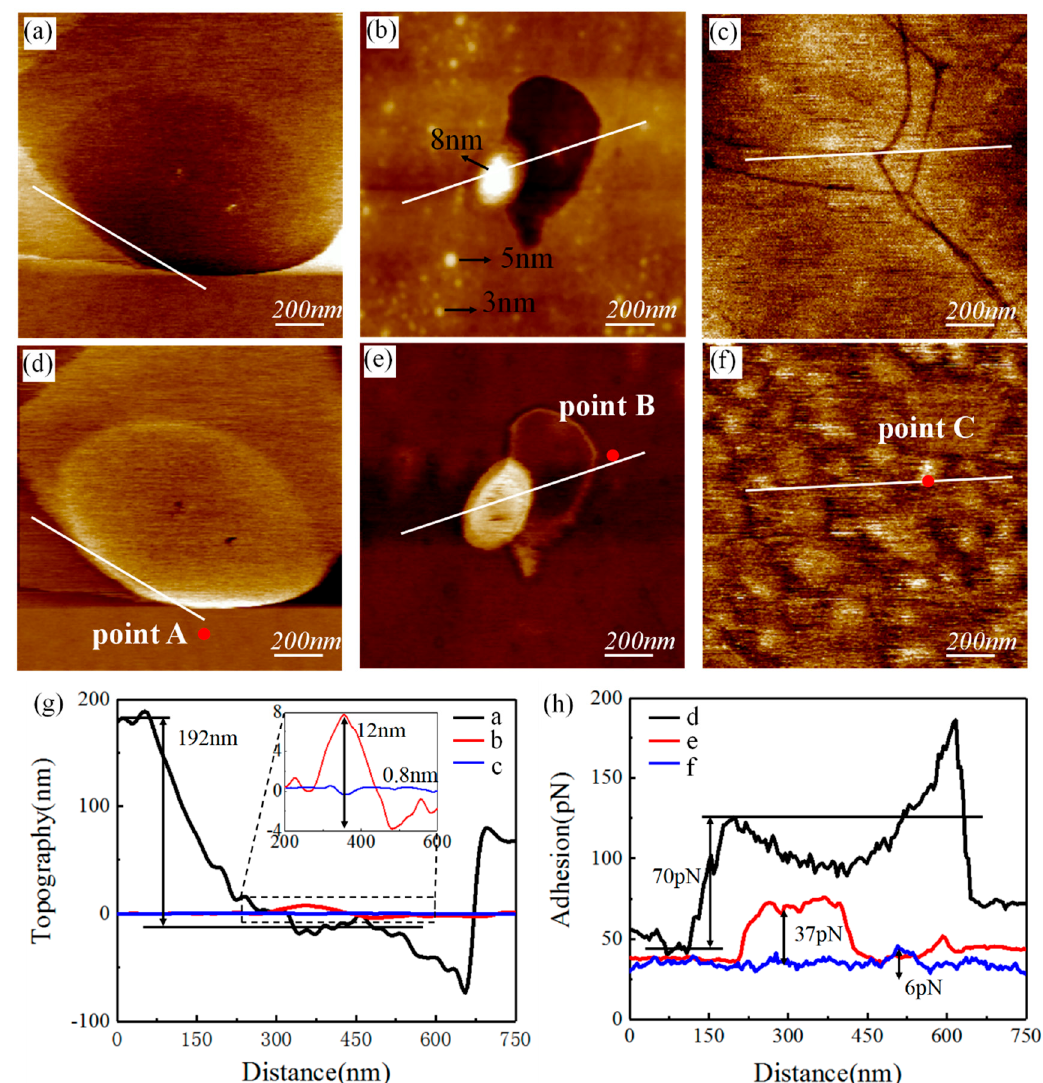
Figure 4. Simultaneous measurement of topography and adhesion in the peak force tapping mode: ( a–c ) topography of paraffin coatings produced by open-type evaporation, closed-type rapid cooling evaporation, and closed-type precise temperature-controlled evaporation (white lines depict the cross section of extracted profiles); ( d–f ) adhesion of paraffin coatings produced by open-type evaporation, closed-type rapid cooling evaporation, and closed-type precise temperature-controlled evaporation (white lines depict the cross section of extracted profiles); ( g ) cross section of the topography corresponding to ( a – c ); and ( h ) cross section of the adhesion corresponding to ( d – f ). Each paraffin coating was evaporated for 75 min.